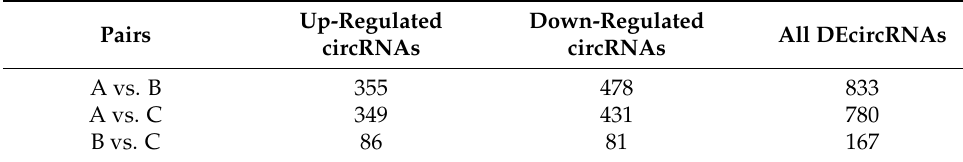
Table 3. Statistics of DEcircRNAs in submandibular glands of goats at different ages. Pairs